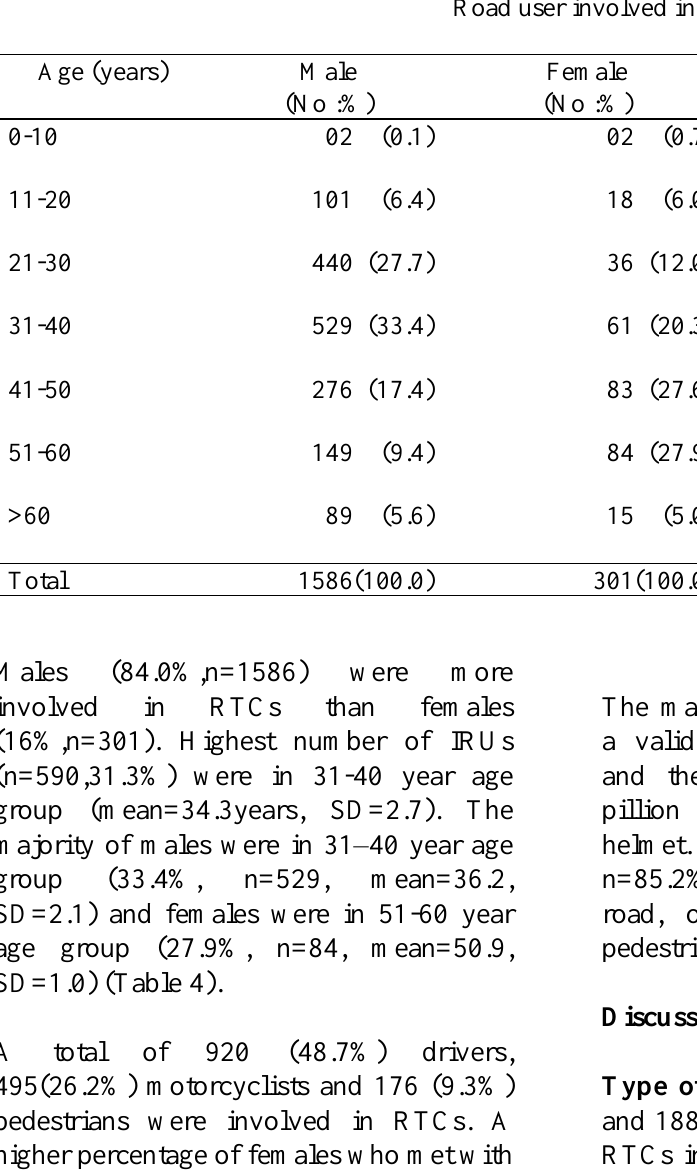
Table 4: Distribution of the gender and age of involved road users in KPD Road user involved in